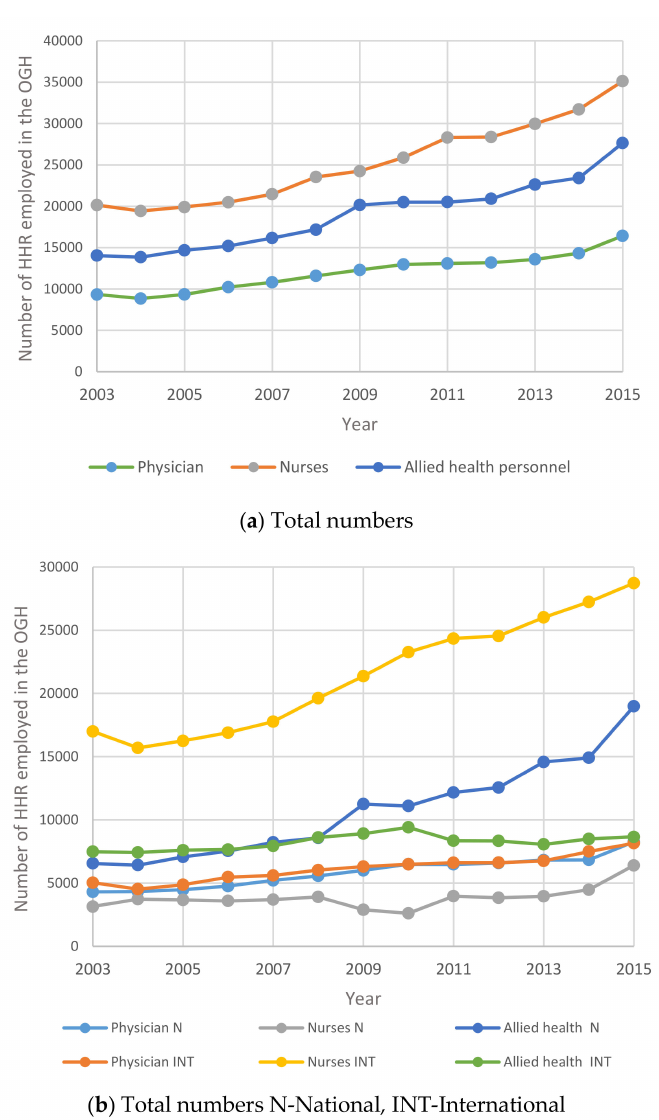
Figure 3. Time Series for HHR in OGH between 2003 and 2015: ( a ) total numbers; ( b ) total numbers N—National; INT—International.